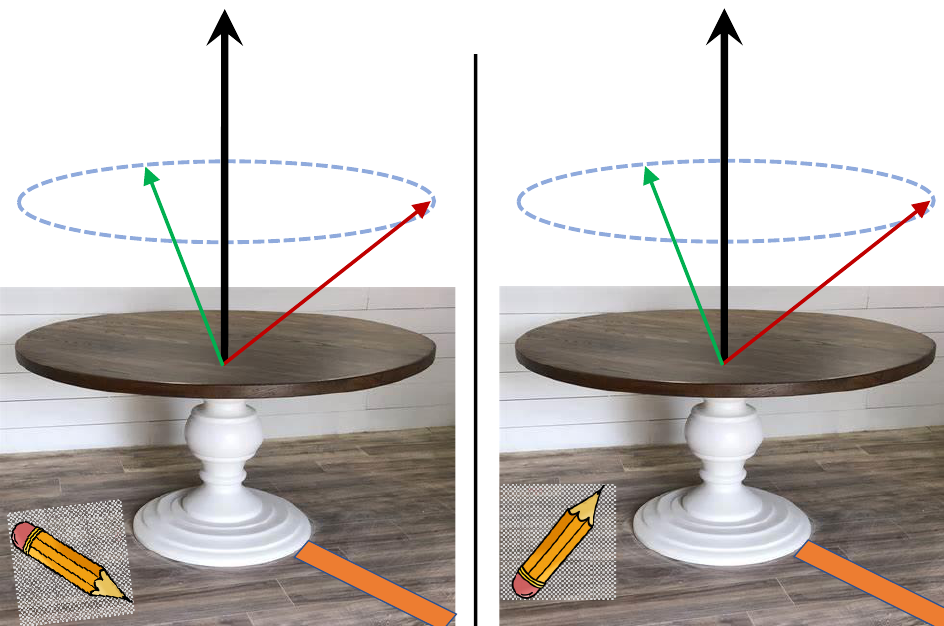
Figure 2. Different identities for the context defined by two detectors (red and green arrows) perform- ing measurements on a qutrit (black arrow) can be obtained by rotating the pencil that lays beside them when the latter serves as our external frame of